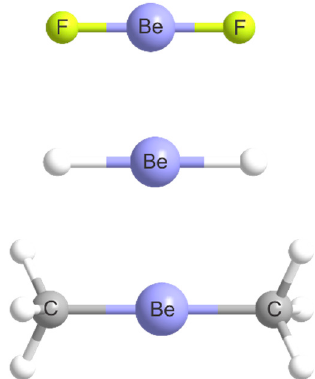
Figure 2. Geometries of BeF 2 , BeH 2 and Be(CH 3 ) 2 optimized at the CCSD(T)/aug-cc-pVTZ level of theory (to scale).